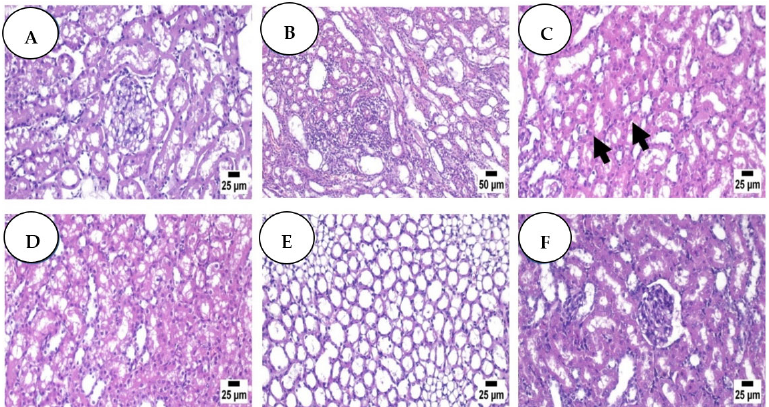
Figure 4. Control group ( A ) high power view shows average glomeruli with average Bowman’s spaces, average proximal tubules with preserved brush borders (black arrow), average distal tu ‐ bules, and average interstitium (H&E); Dox group ( B ) showing focal cystic dilation of renal tubules with focal interstitial nephritis (H&E); Dox + H group ( C ) showing apparently normal renal cortex with few tubules containing renal cast (arrow) (H&E); ( D ) (Dox + R), showing some degenerating renal tubules (H&E); Dox + P group ( E ) showing apparently normal renal medulla (H&E); Dox + H + R + P group ( F ) showing apparently normal renal cortex (H&E).